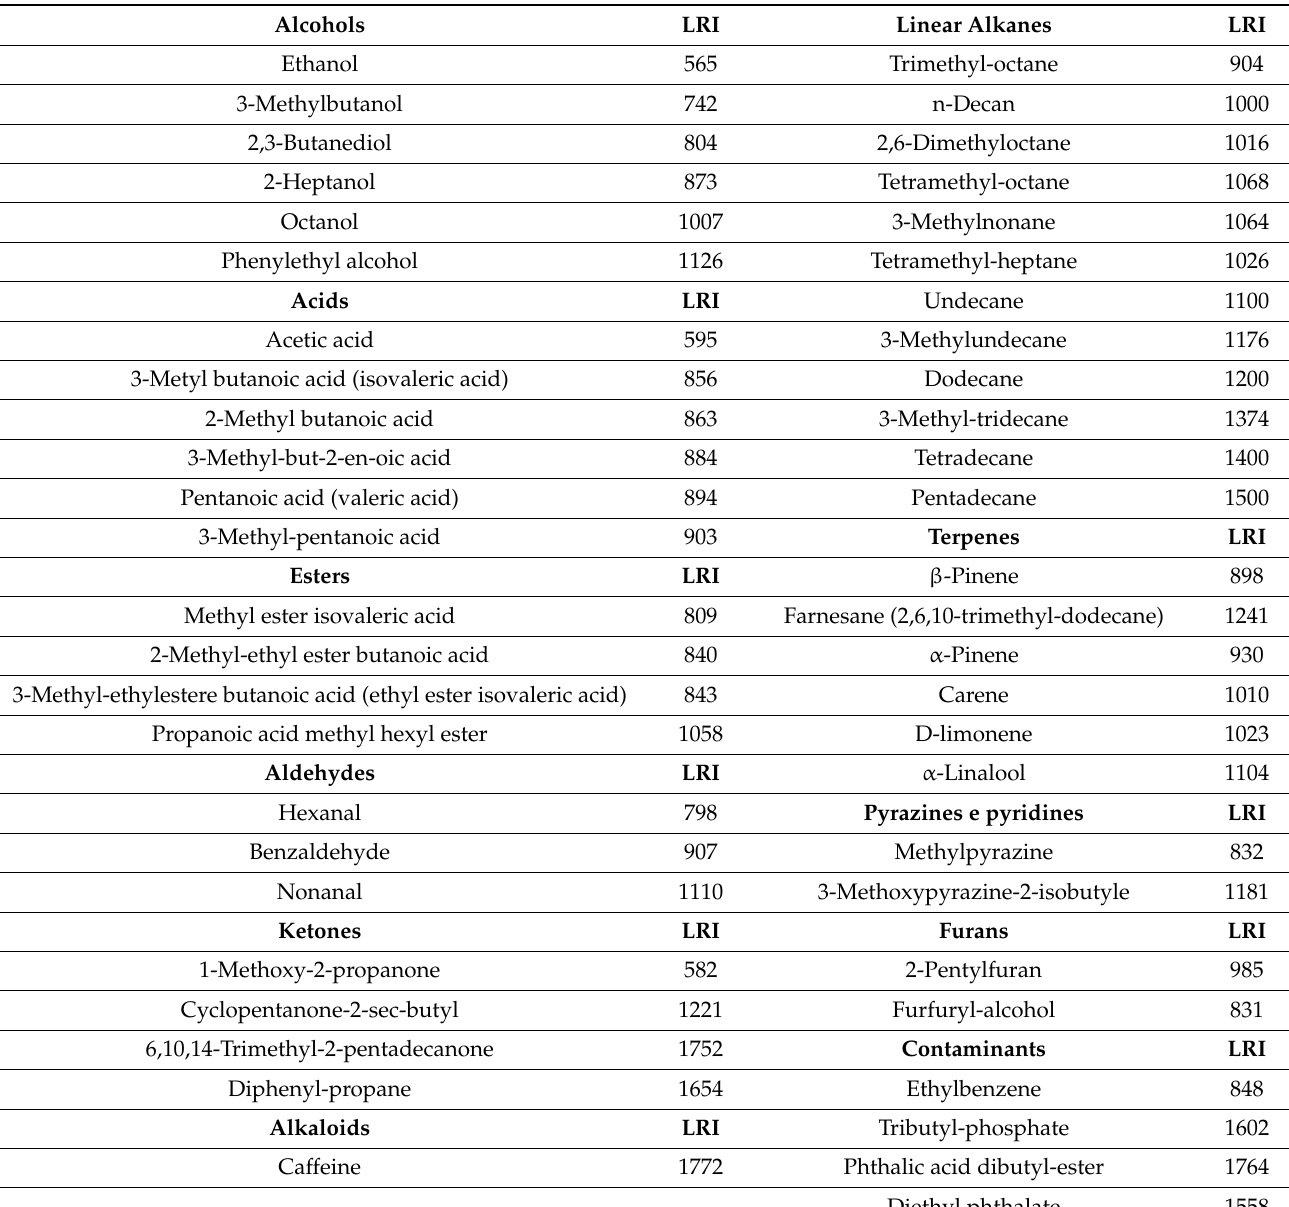
Table 1. List of compounds and related Linear Retention Index (LIR) detected in the green coffee headspace, listed by chemical